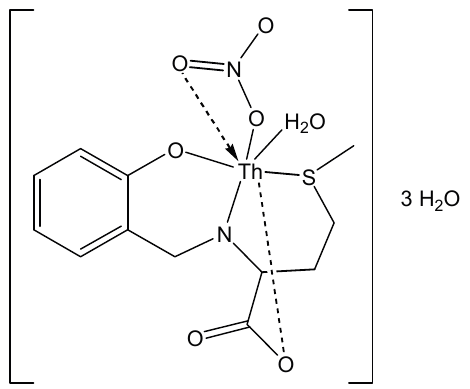
Figure 16. Structure of the suggested metal